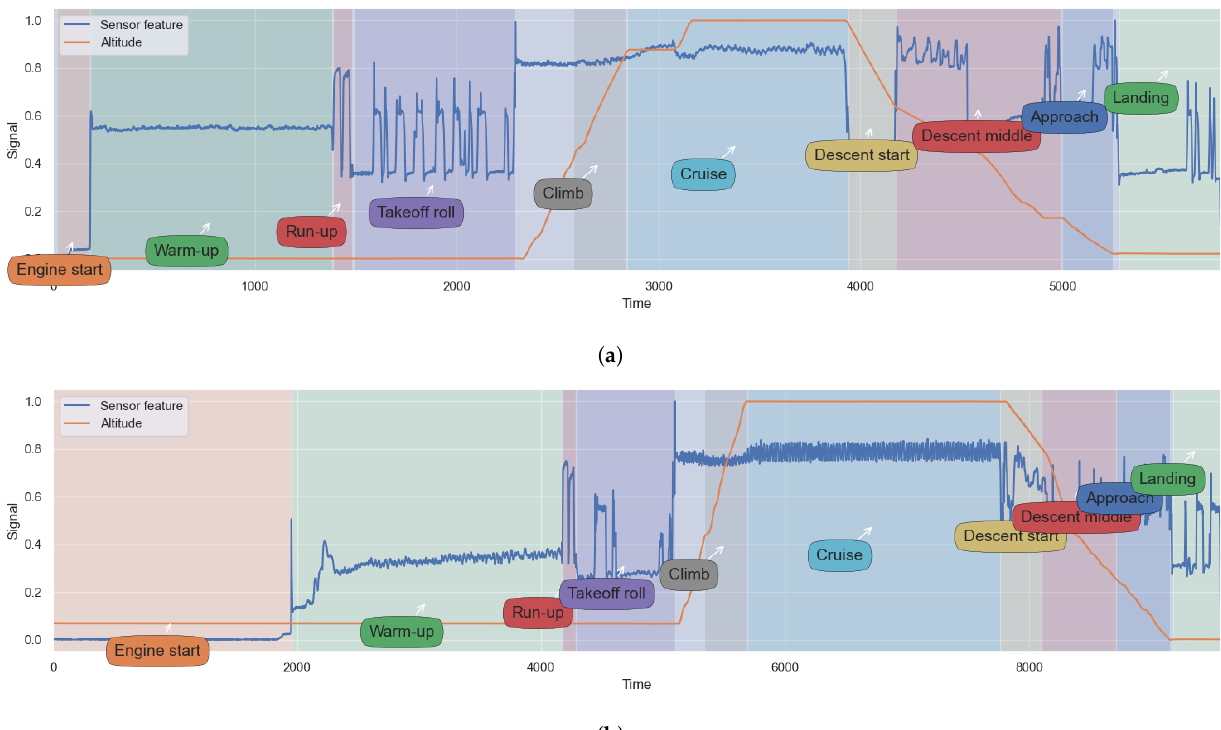
Figure 6. Baselining flowchart. To baseline the operational data, a rule-based segmentation process is utilized on flight altitude and binary control variables. The final step consists of kernel change-point detection, based on multidimensional data that include condition monitored variables in addition to control variables and the altitude parameter to discriminate between the flight phases of the climb, cruise, and takeoff.